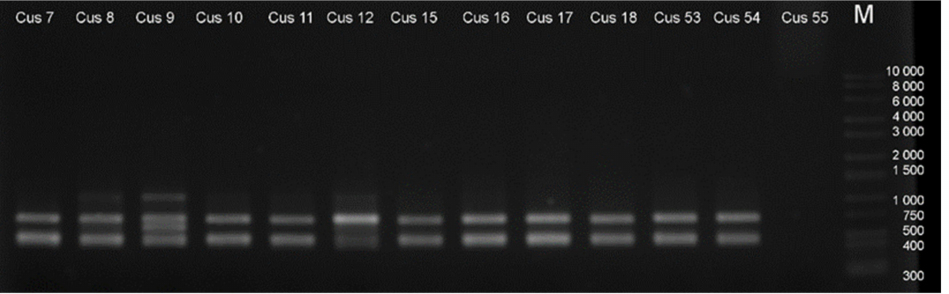
Figure A2. A representative electropherogram of RAPD amplification products (with primer OPB-17) of C. campestris